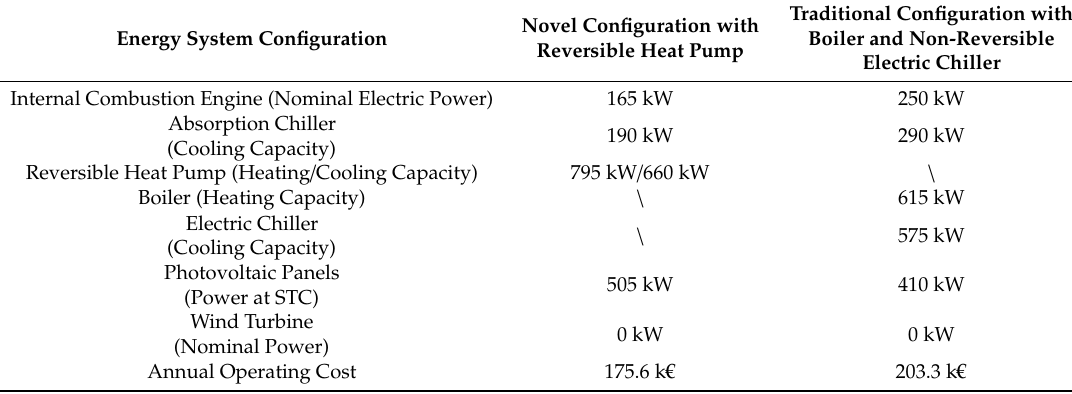
Table 3. Optimal Equivalent Annual Cost: sizing and